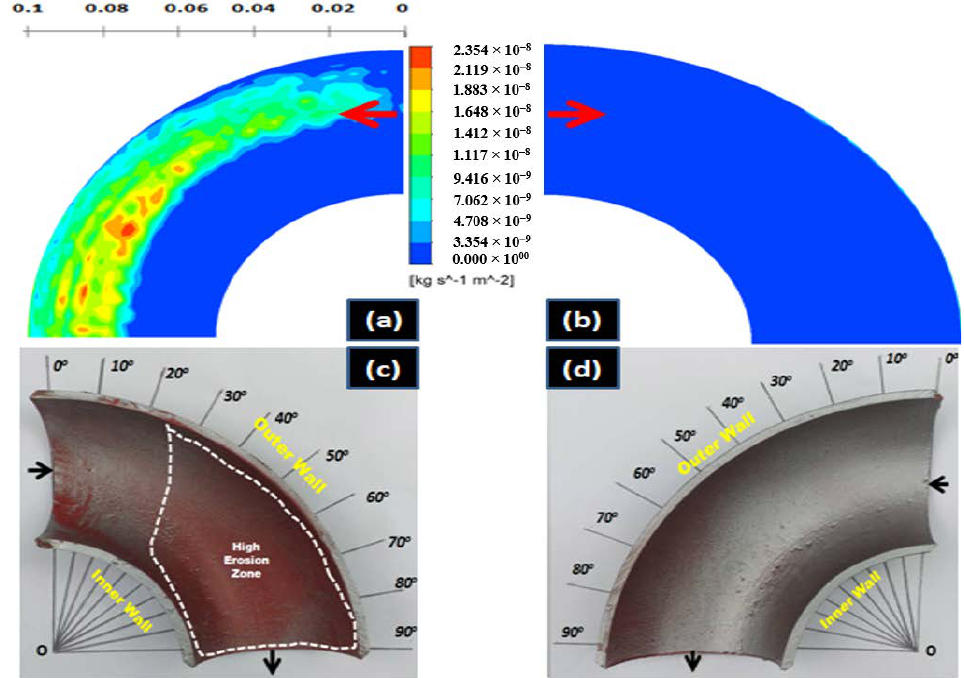
Figure 12. Comparison of erosion pattern for 90-degree elbow, between prediction and MPM experiments at 1 m/s. ( a ) bottom section (CFD) ( b ) upper section (CFD) ( c ) bottom section (MPM) ( d ) upper section (MPM). Metals 2020 , 10 , x FOR PEER REVIEW